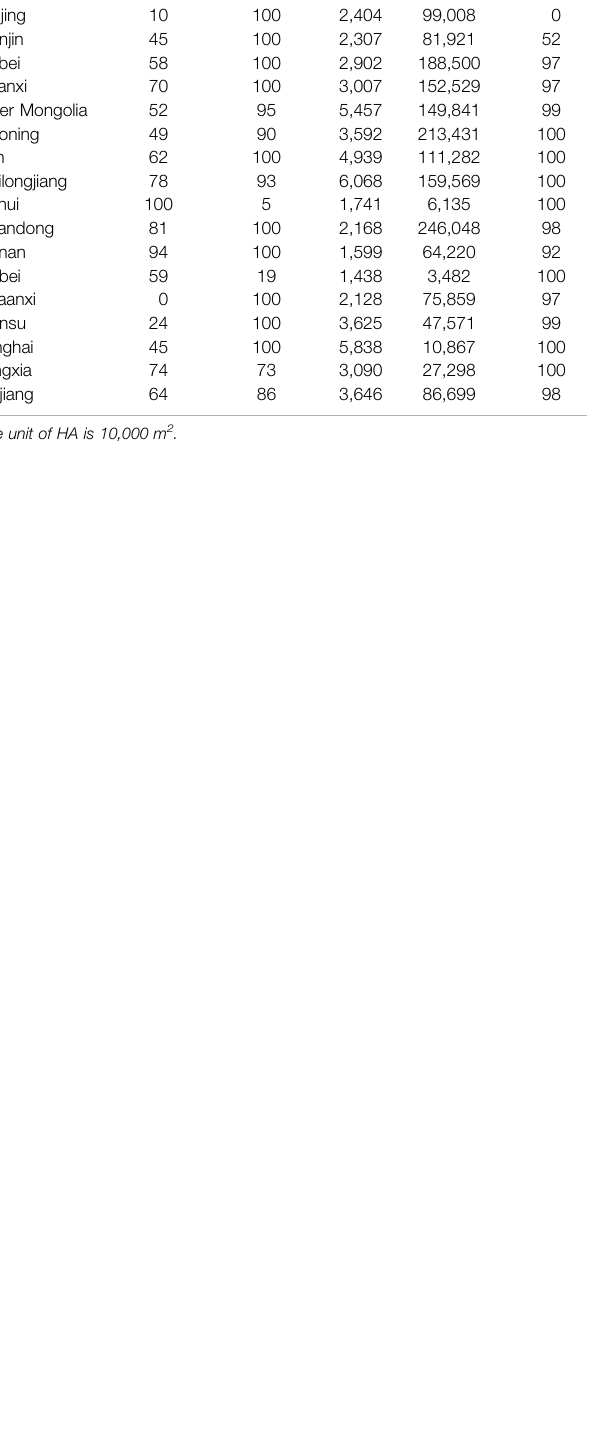
TABLE A1 | Predicted values of in fl uencing factors in the fi eld of central heating in 2030. PCH (%) PWH (%) HDD